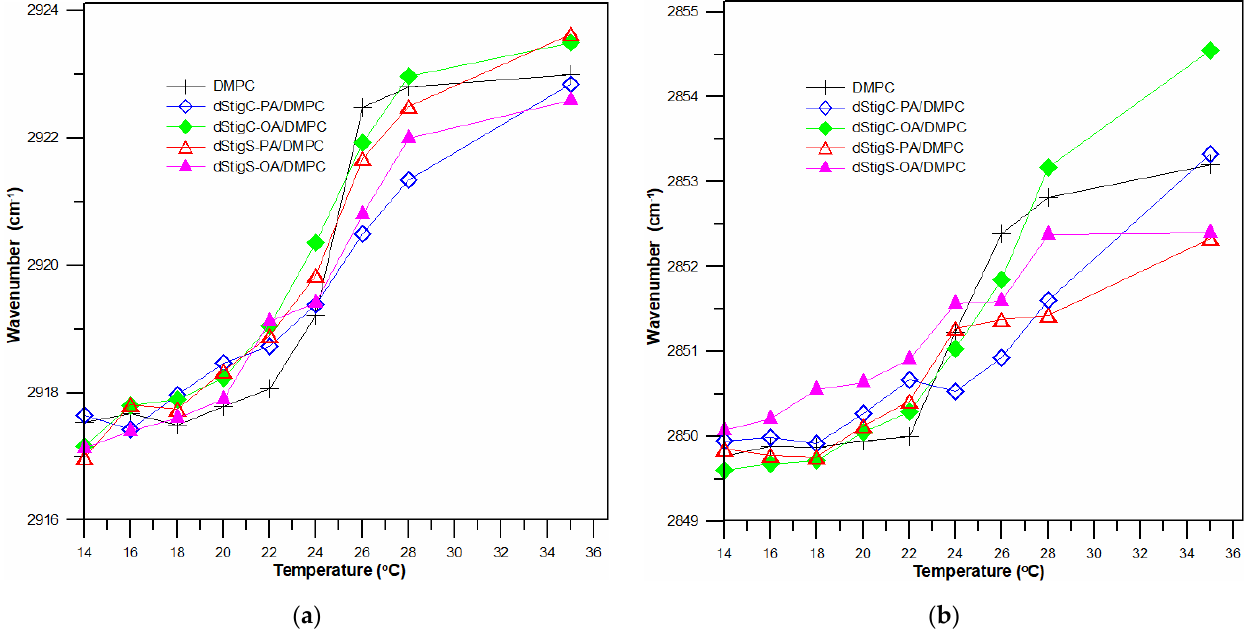
Figure 8. Dependence of vibration frequency on system temperature of the CH 2 asymmetric ( a ) and symmetric ( b ) stretching mode in the presence and absence of dStigMAs for DMPC bilayer; n dStigMAs /n DMPC = 0.20.